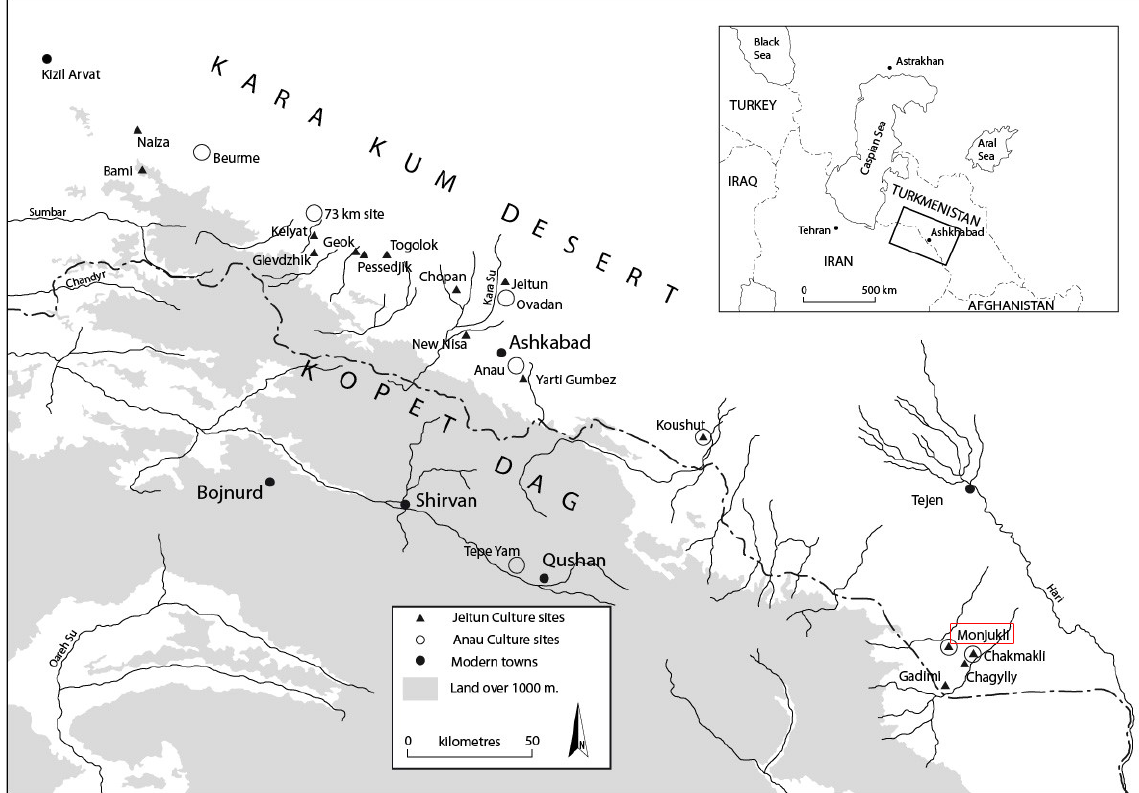
Figure 1. Monjukli Depe and other sites with Neolithic (Jeitun Culture) and Aeneolithic (Anau IA Culture) material (modified from Pollock et al . 2011: fig.